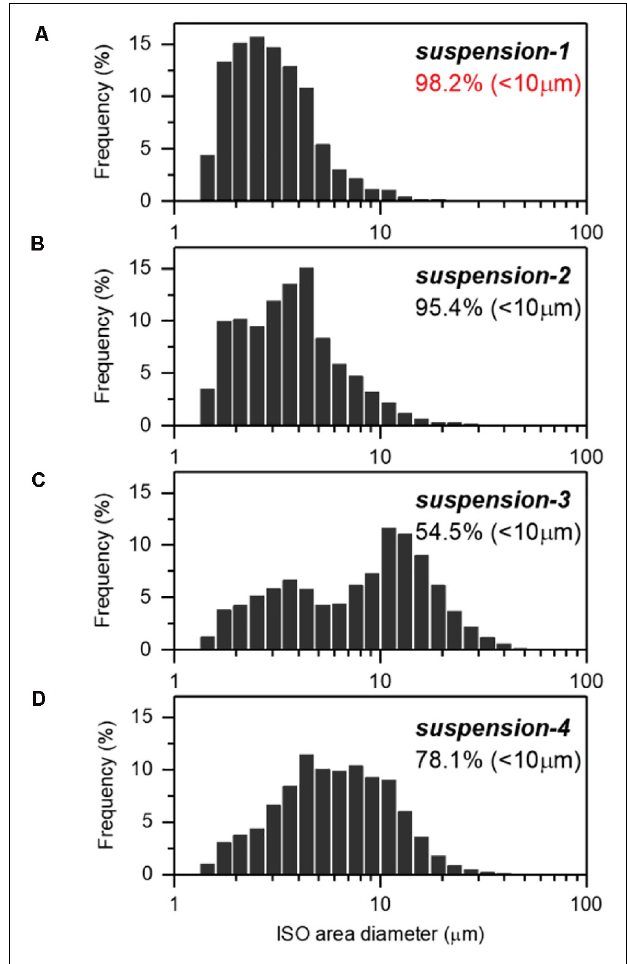
FIGURE 6 | Size distribution of CNT aggregates measured by flow image analyzer of (A) , suspension 1, (B) suspension 2, (C) suspension 3, (D) suspension